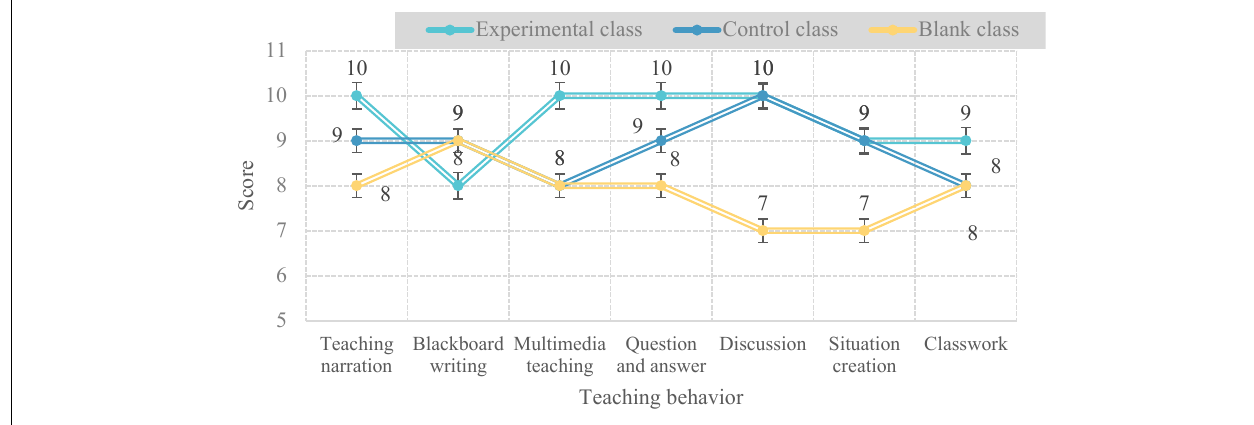
FIGURE 2 | Teachers’ evaluation of the effectiveness of teaching behavior.